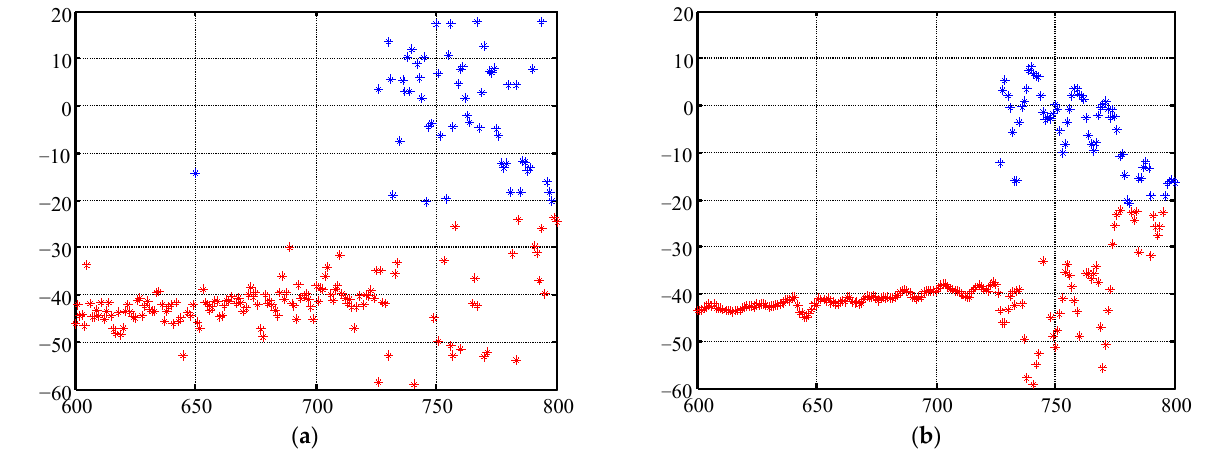
Figure 6. Height distribution of scattering points. ( a ) Traditional L1 norm compressive sensing method; ( b ) Multi-look compressive sensing method. The horizontal axes represent pixels from 600 to 800 in the slant range, and the vertical axes are heights in the elevation direction with the unit m.